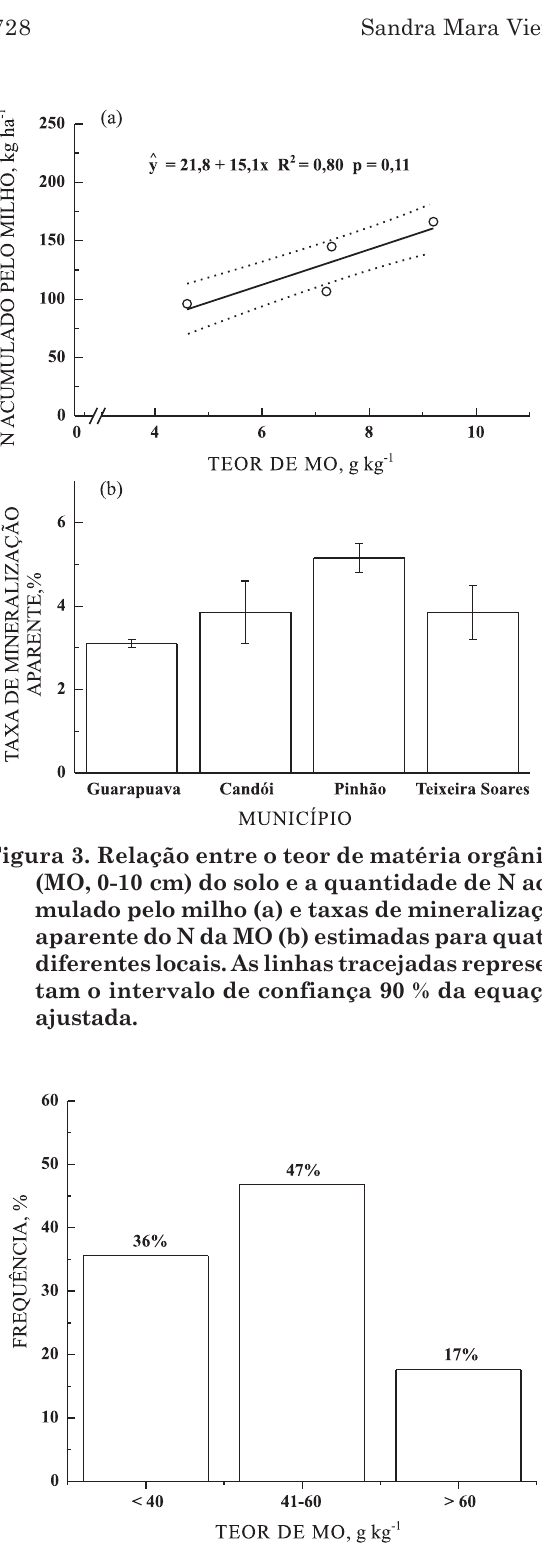
Figura 4. Frequência de ocorrência do teor de MO na camada de 0–10 cm, na região centro-sul do PR (3.800